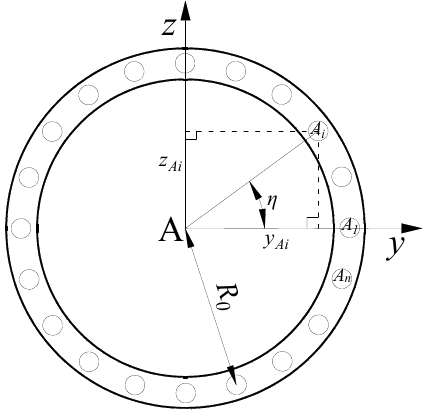
Figure 2. Layout diagram of thrust cylinders.